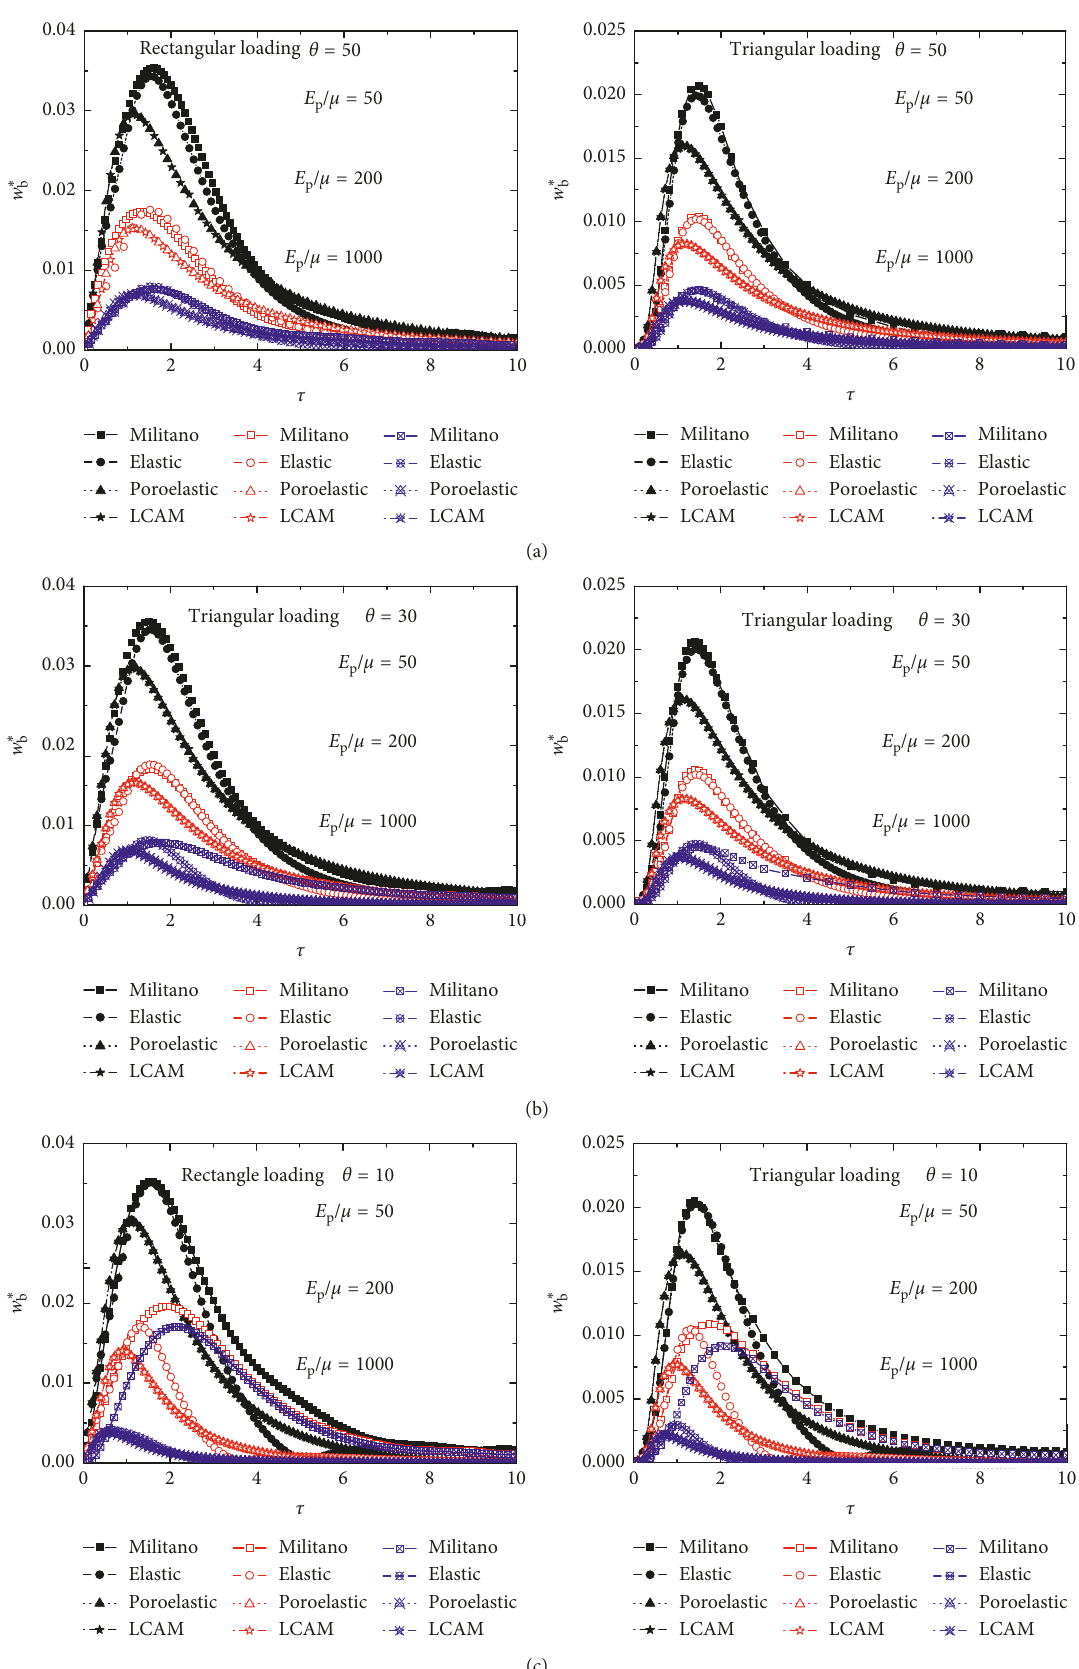
Figure 4: Comparisons of dynamic response of pile in the time domain, under rectangle and triangle loading pulses, between the present solution and other solutions. (a) θ